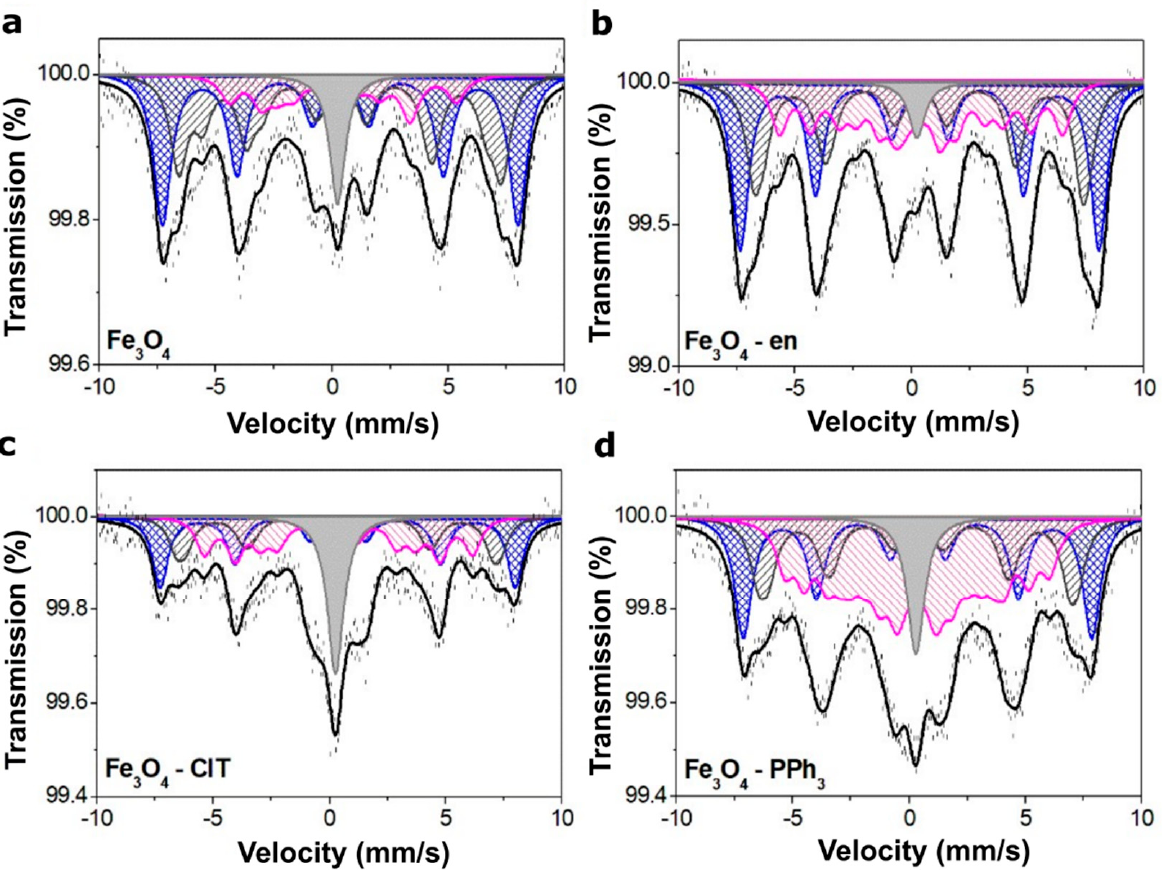
Figure 4. Mössbauer spectra of magnetite nanoparticles synthesized without ( a ) and with the presence of different organic modifiers: en ( b ), ClT ( c ), and PPh 3 ( d ). The contribution of the γ -Fe 2 O 3 is displayed in blue, and that of the Fe 3 O 4 is displayed in dark grey; the sextets connected with the magnetic interaction between nanoparticles are displayed in magenta, and the contribution of superparamagnetic fine particles is displayed in light gray. Table 3. Hyperfine parameters of the synthesized samples (isomer shift ( I s ), quadrupole splitting ( Q s ), hyperfine magnetic field ( H ), and relative area ( A )).